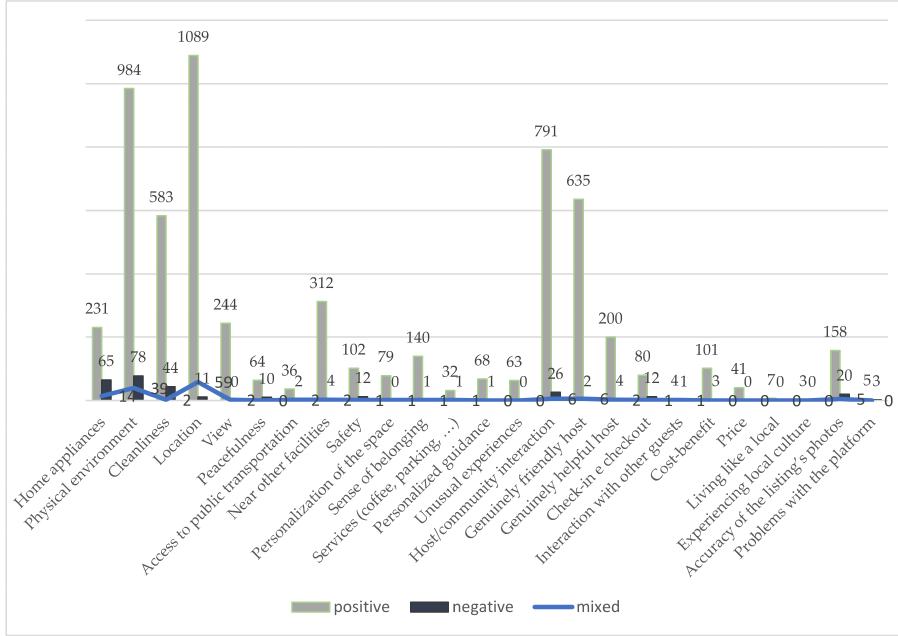
Figure 7. Polarity by themes that identified the user experience in the